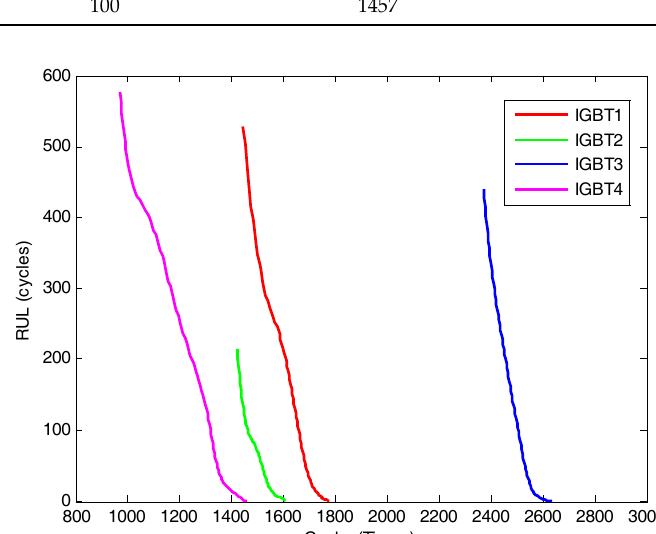
Figure 10. The predicted RULs of the four IGBTs.